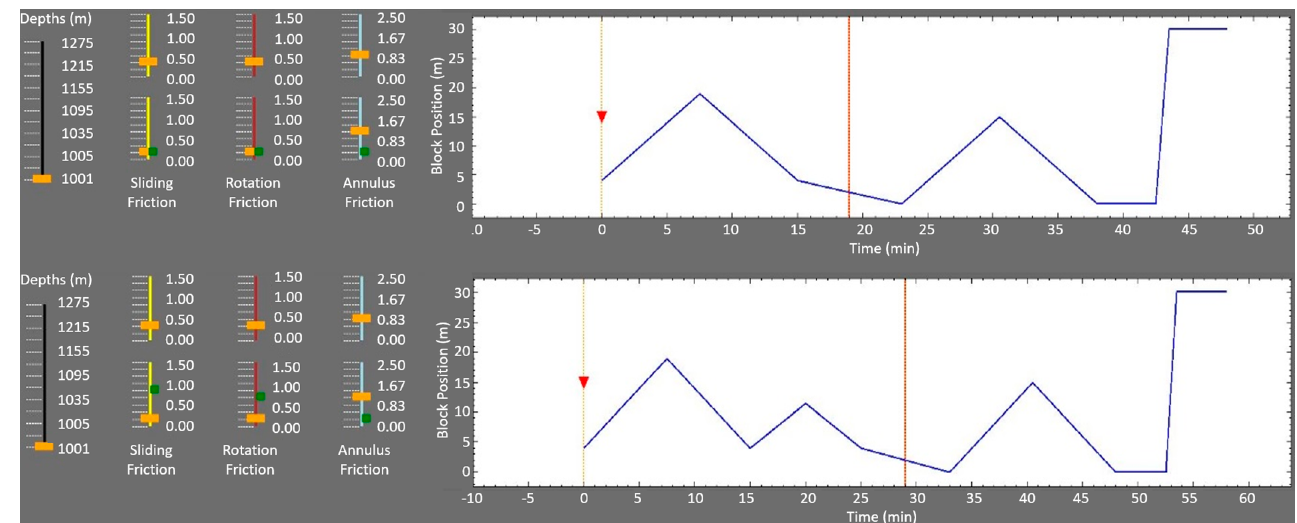
Figure 14. Effect of uncertainty on the decision-making. The uncertainty in friction estimation is high in the low plots (the standard deviations are indicated by the green markers). In this situation, the system recommends performing a friction test in addition to the reciprocation sequence.